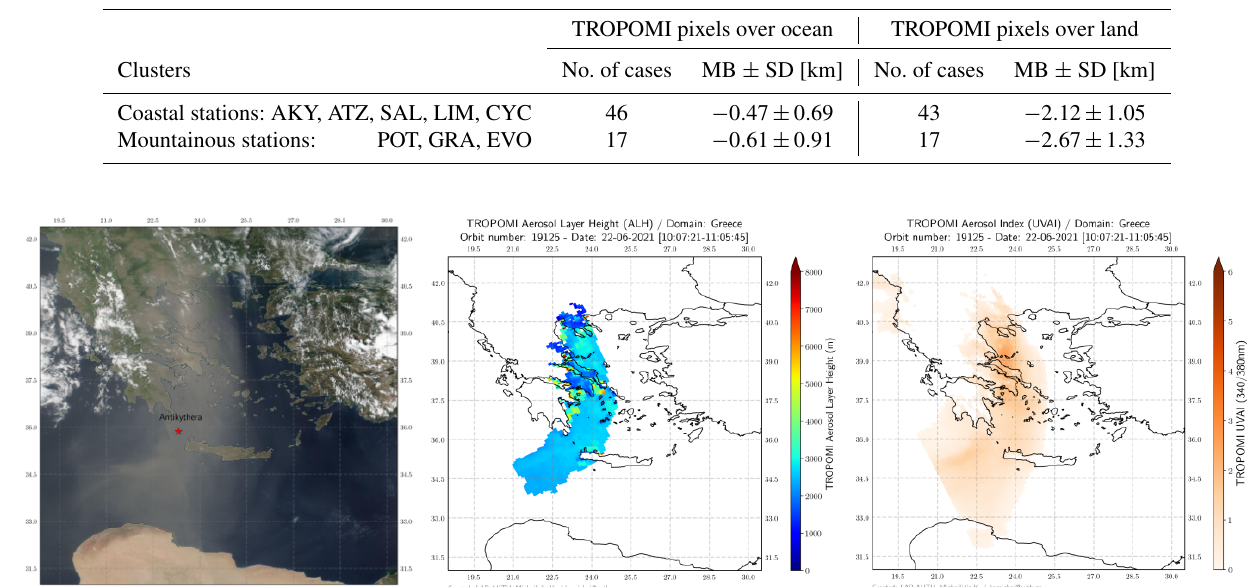
Figure 3. Suomi-NPP VIIRS (left) true-colour image on the 22 June 2021. The red star indicates the position of the Antikythera lidar station. TROPOMI ALH (centre) and TROPOMI UVAI (right) over